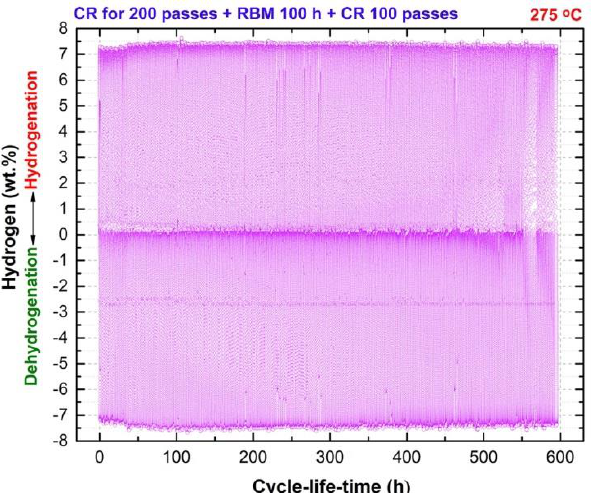
Figure 9. CLT conducted under 10 bar (hydrogenation)/400 mbar (dehydrogenation) of H 2 at 350 °C for Mg-rods obtained after 200 passes. The as-CR rods were then RBM for 100 h and then CR for 100 passes.